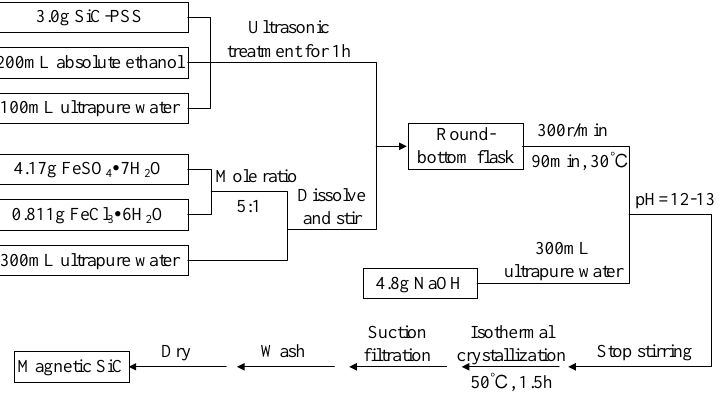
Figure 2. Preparation process of magnetic SiC (M-SiC).